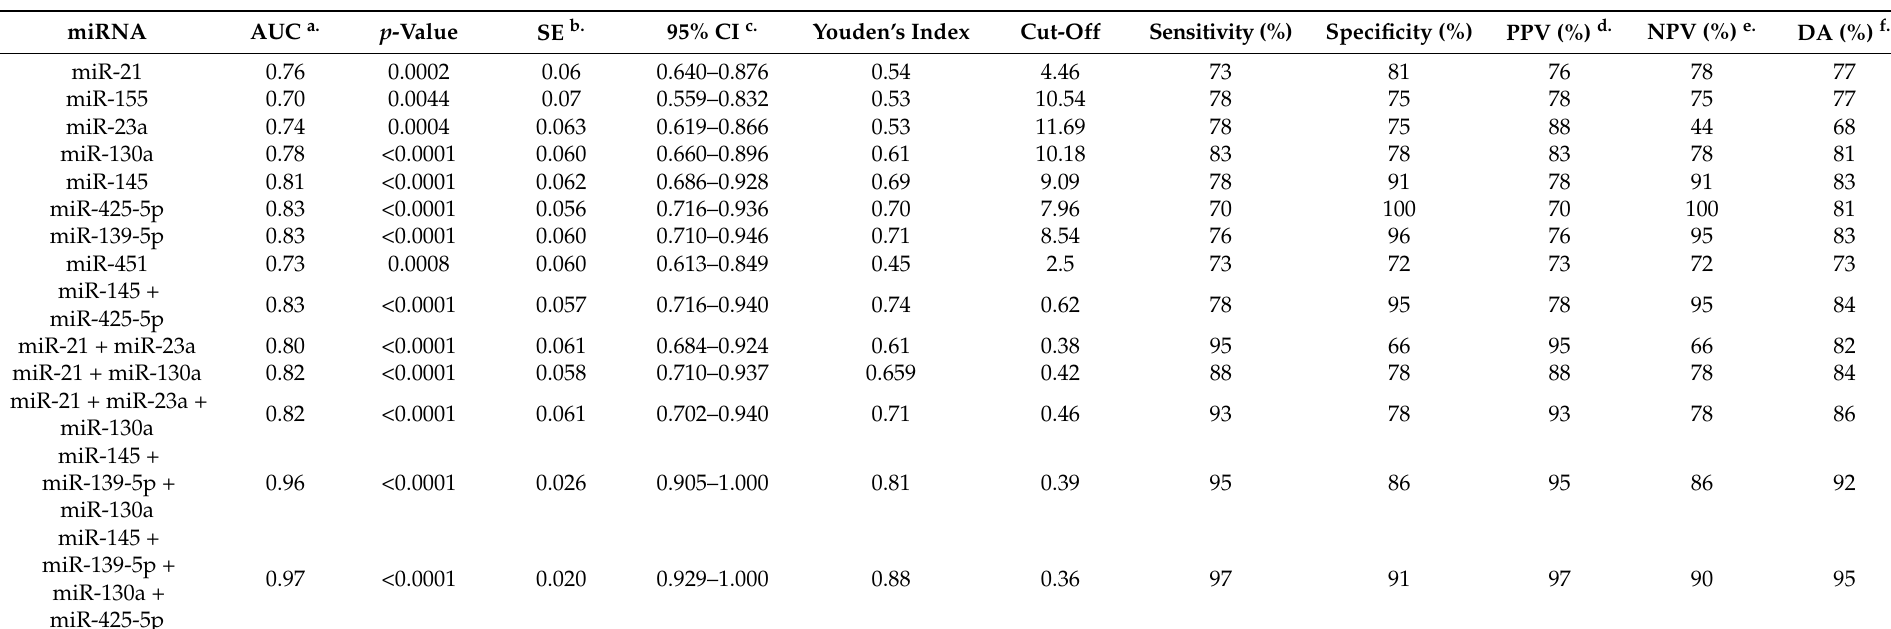
Table 2. Diagnostic parameters to evaluate the early-stage BC diagnostic ability of individual and combined studied miRNA. The ROC curve reports the AUC of each miRNA. Youden’s index was calculated to determine the cut-off value, sensitivity, specificity, PPV, NPV, and DA of each miRNA. Predicted probabilities were calculated and utilized in case of combined miRNA